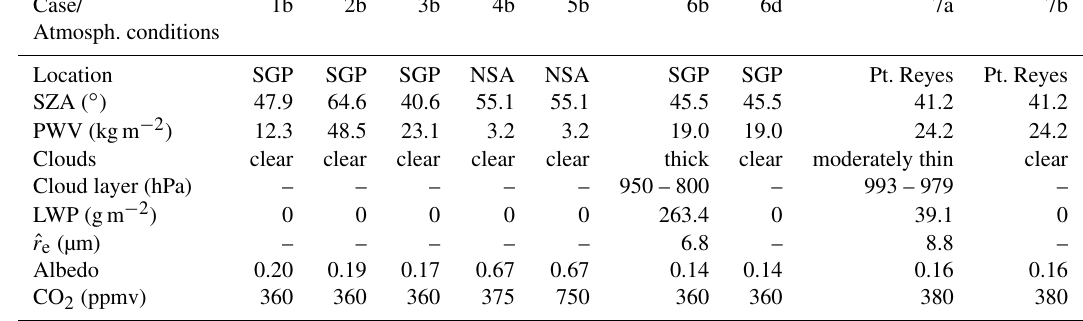
Table 1. CIRC experiments (SGP = Southern Great Plains, NSA = Northern Slope of Alaska). Clouds in 6b and 7a consist of liquid water droplets.